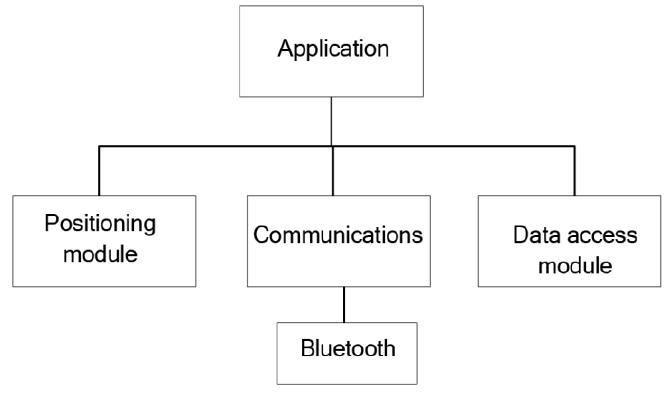
Figure 10. Modular structure of the Information